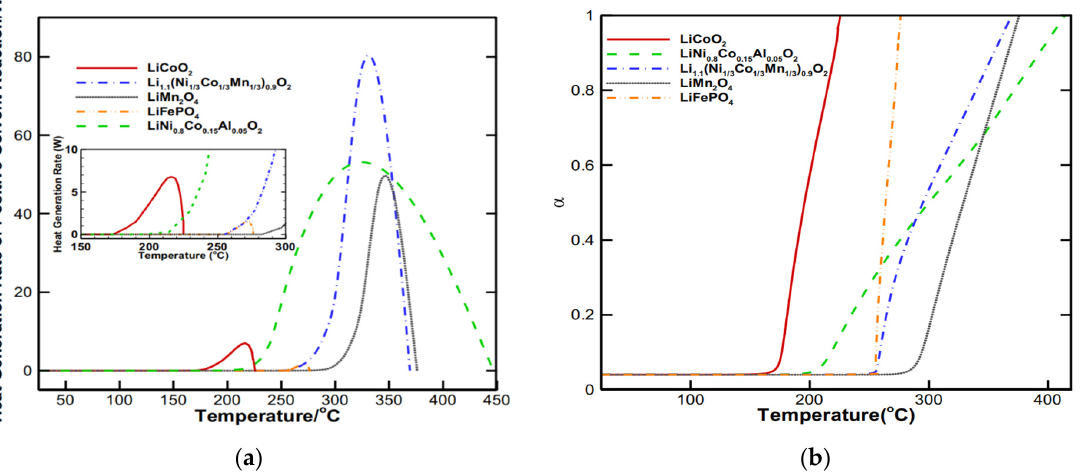
Figure 7. Comparison of thermal runaway reaction of different cathode materials [55]: ( a ) Comparison of reaction degrees; ( b ) comparison of heat generation rates.